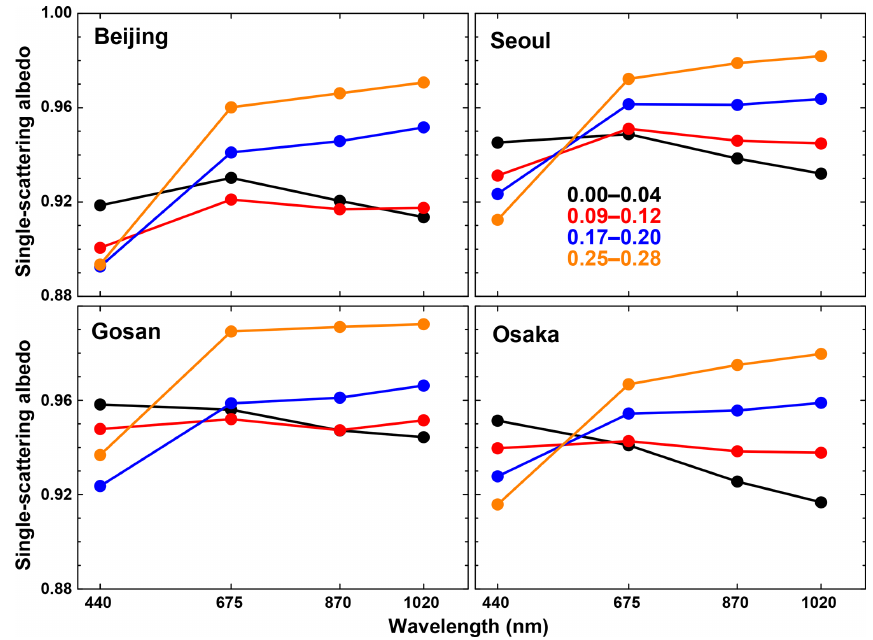
Figure 1. The mean spectra of SSA for different ranges of PLDR at the East Asian AERONET sites considered in this